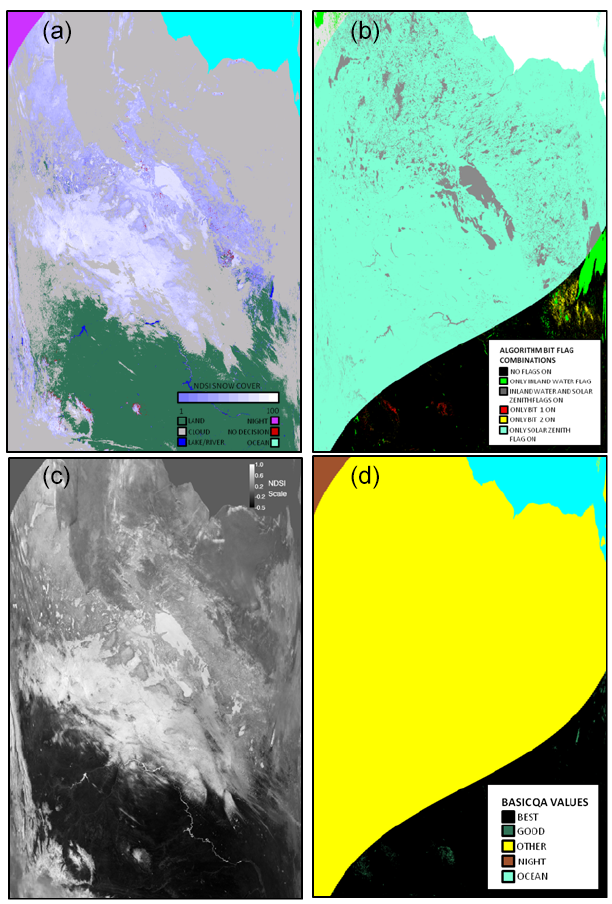
Figure 9. MODIS C6 MOD10_L2.A2003010.1750, imaging the Great Plains and boreal forest in North America. Datasets: NDSI_Snow_Cover (a) , NDSI (c) ; a selected combination of the Algorithm_bit_flag QA is shown in (b) ; and the basic QA is shown in (d) .